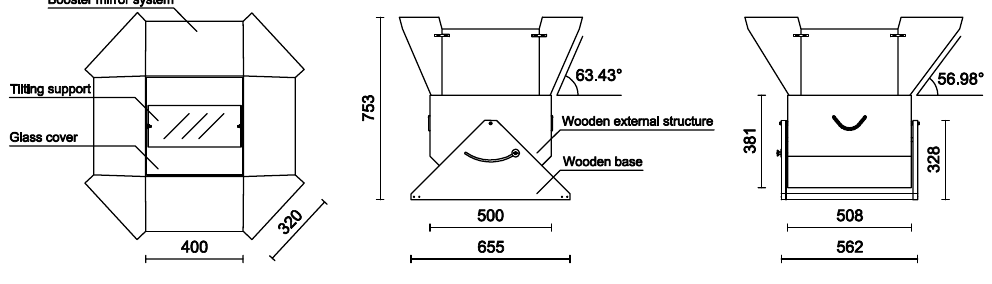
Figure 5. Portable solar box cooker. Table 4. Thermo-optical properties of the solar box